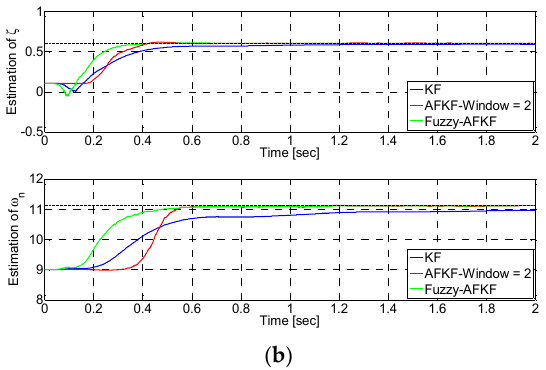
Figure 4. Results of normal parameter estimations: ( a ) standard Kalman filter and adaptive fading